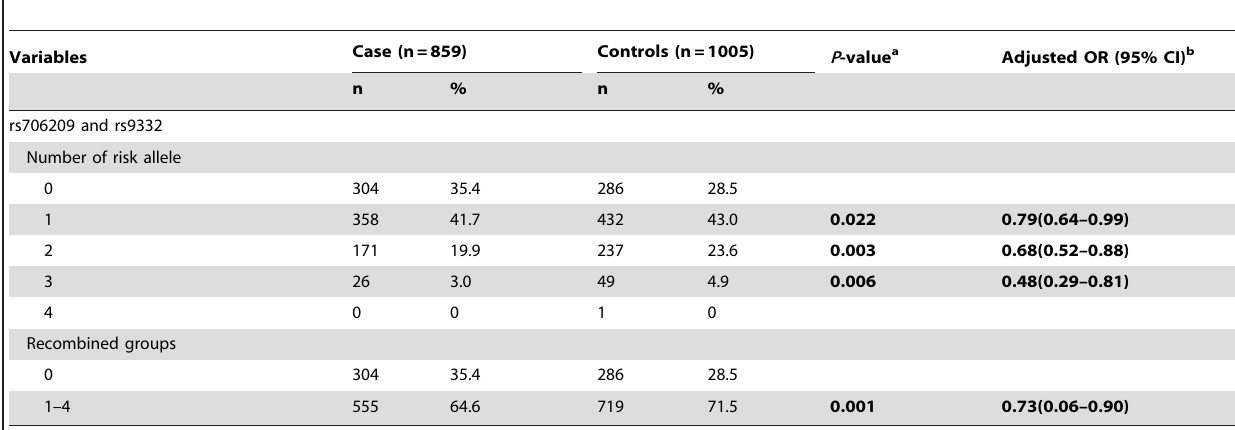
Table 3. Combined genotype frequencies among the case patients and control subjects and their collection to clear cell renal cell carcinoma.